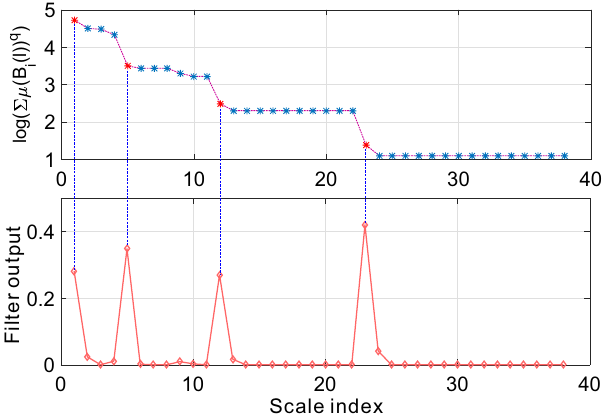
Figure 19. An example application of the proposed data-driven filtering method. By applying the filter sliding through the observations, the peaks of the output correspond to the critical scales where a significant change of the accumulative measure ∑ μ ( B i ( l )) q